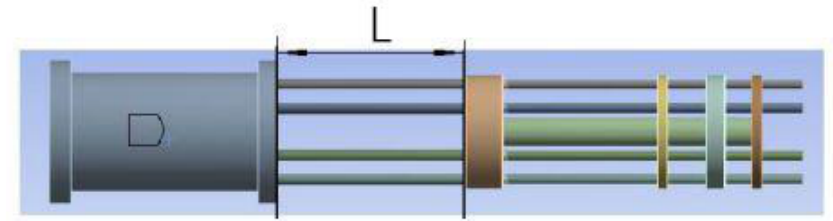
Figure 19. The distance from the second enclosure to the body part is L.